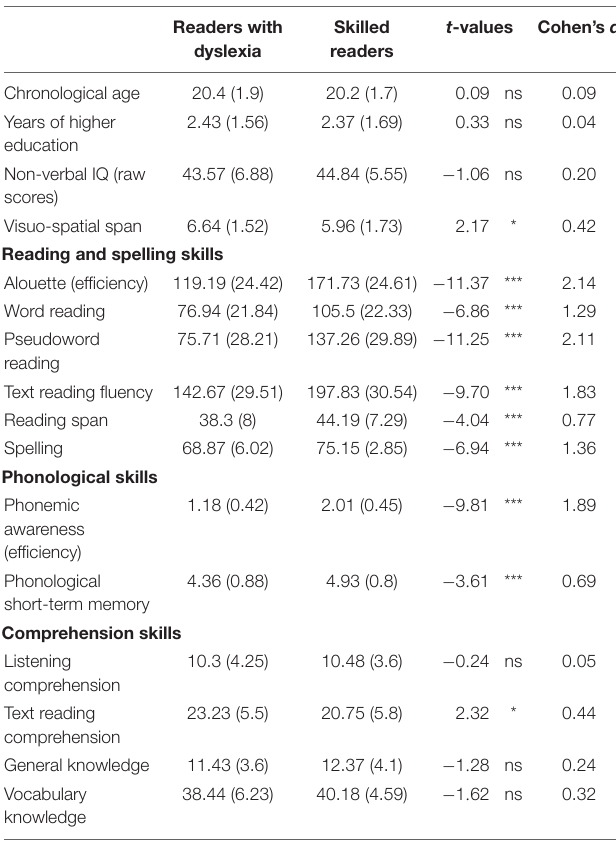
TABLE 1 | Cognitive profiles of readers with and without